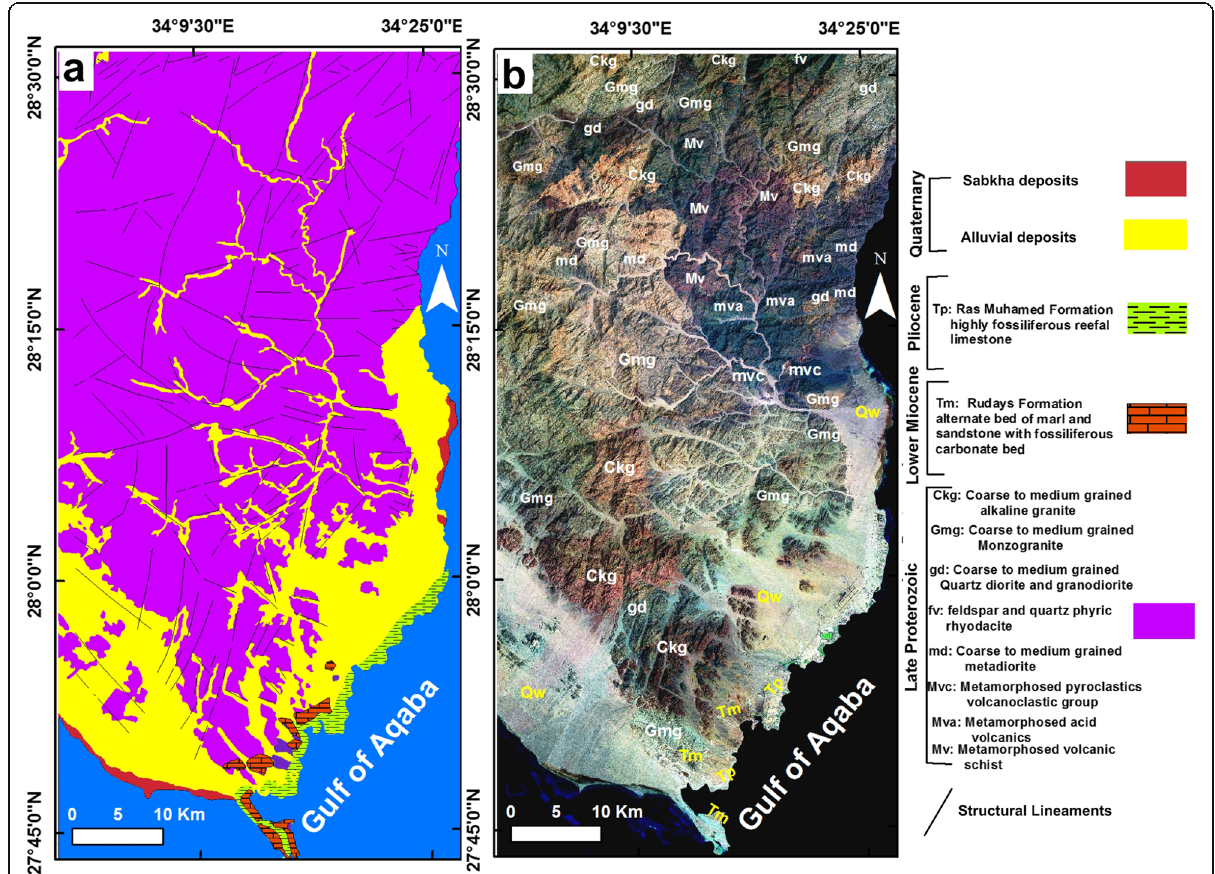
Fig. 2 Geologic setting of the study area and its vicinities. a Lithologic map showing the basement complex (one unite) and sedimentary exposures (EGSMA 1994). b Detailed geologic units are clarified on the false color composite (RGB, 7, 4, 2) of Landsat 7 ETM +